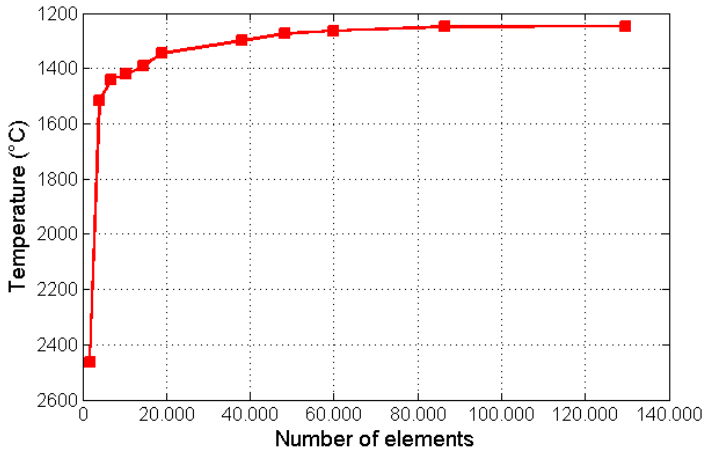
Figure 5. Mesh refinement based on the maximum temperature in the weld pool. Table 3. Number of elements of the FEM mesh of each region studied (indicated in Figures 6 and 7). Model